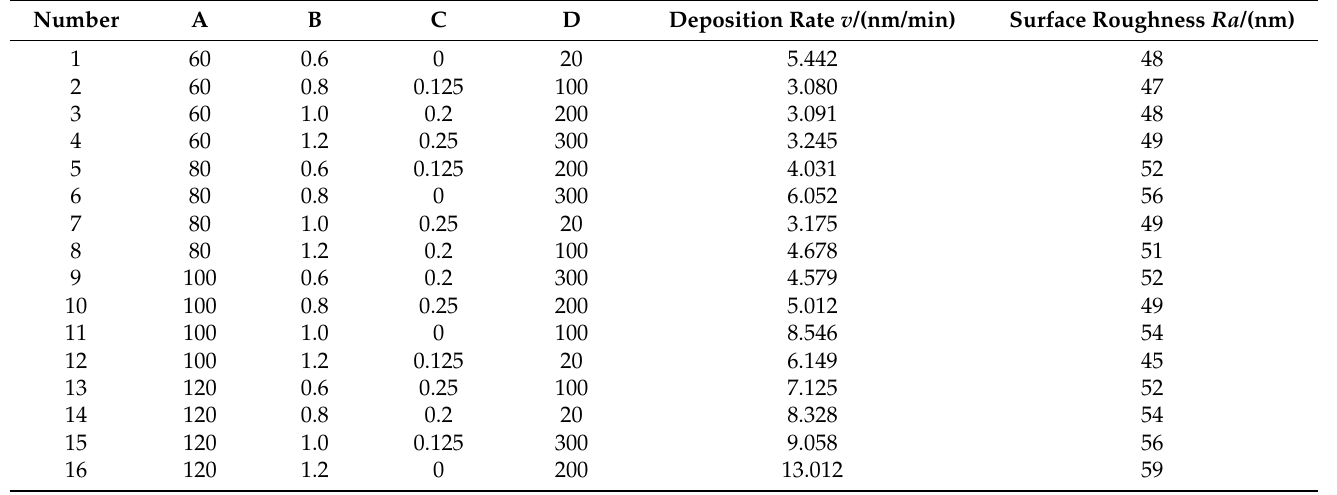
Table 4. L 16 (4 4 ) Orthogonal test design and results of Si 3 N 4 film.